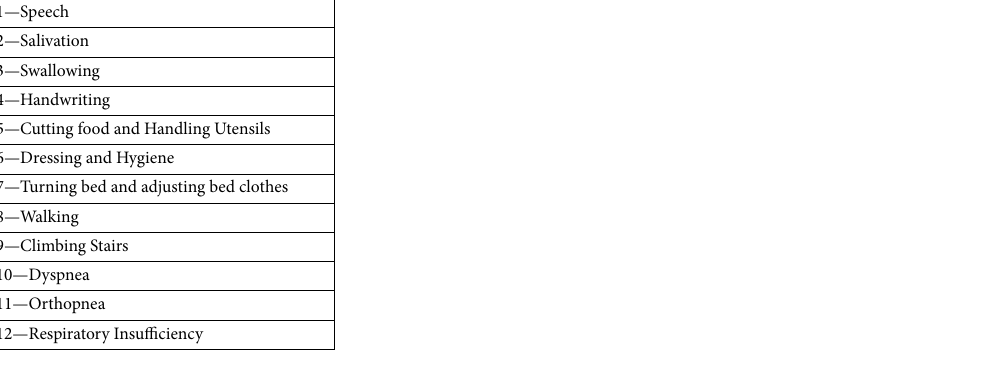
Table 2. ALSFRS-R questions.